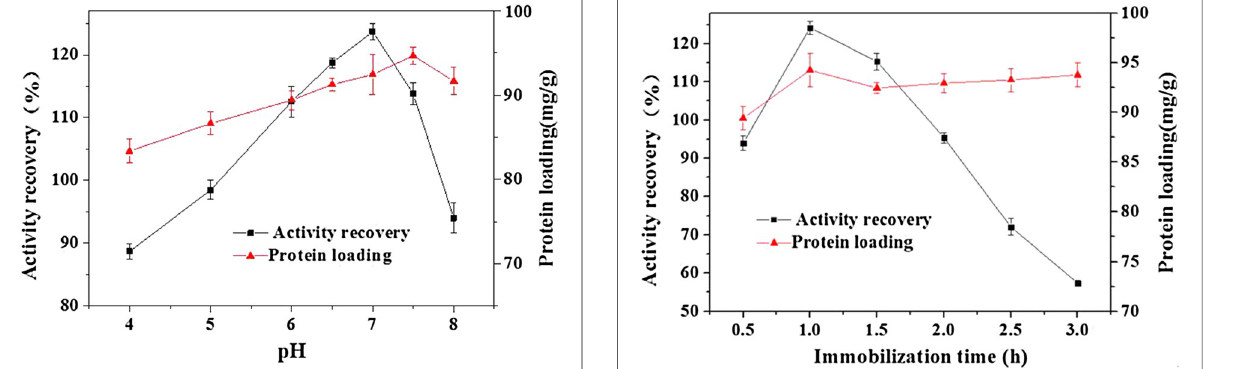
Fig. 7 Effects of immobilization time on activity recovery and enzyme loading of immobilized GOx